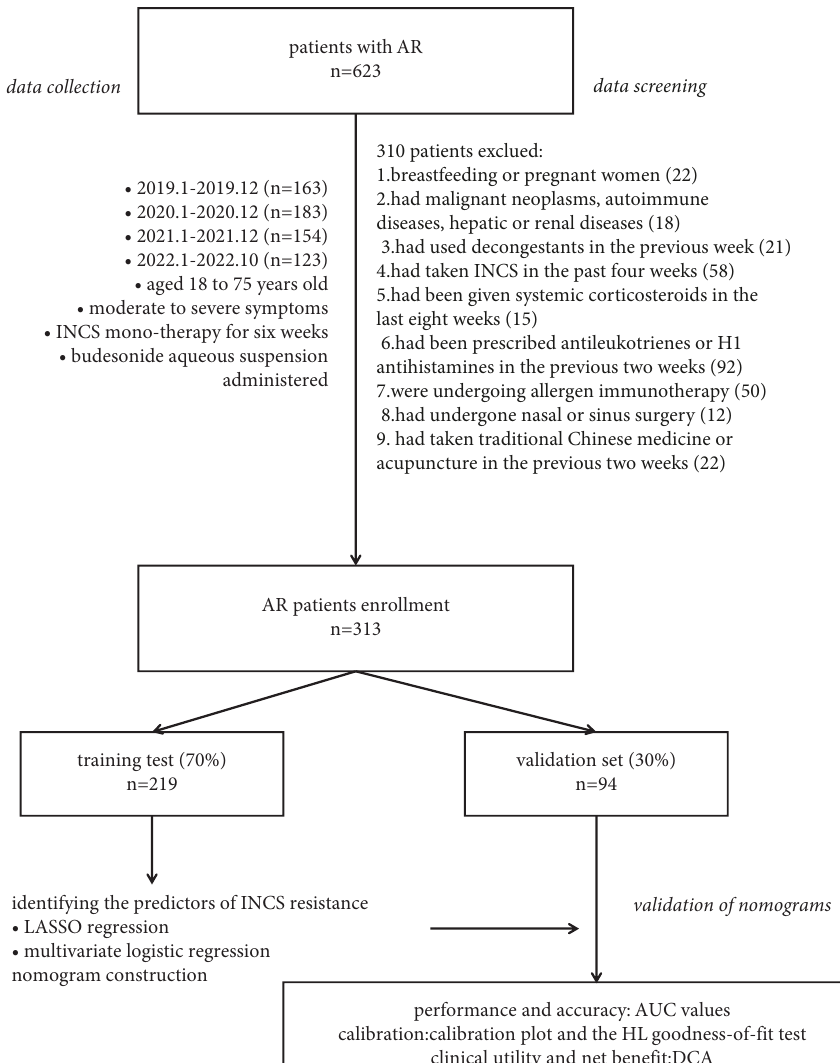
Figure 1: Te patient screening process and the study design. AR: allergic rhinitis, INCS: intranasal corticosteroids, LASSO: least absolute shrinkage and selection operator, AUC: curves and areas under the curves, HL: Hosmer–Lemeshow, and DCA: decision curve